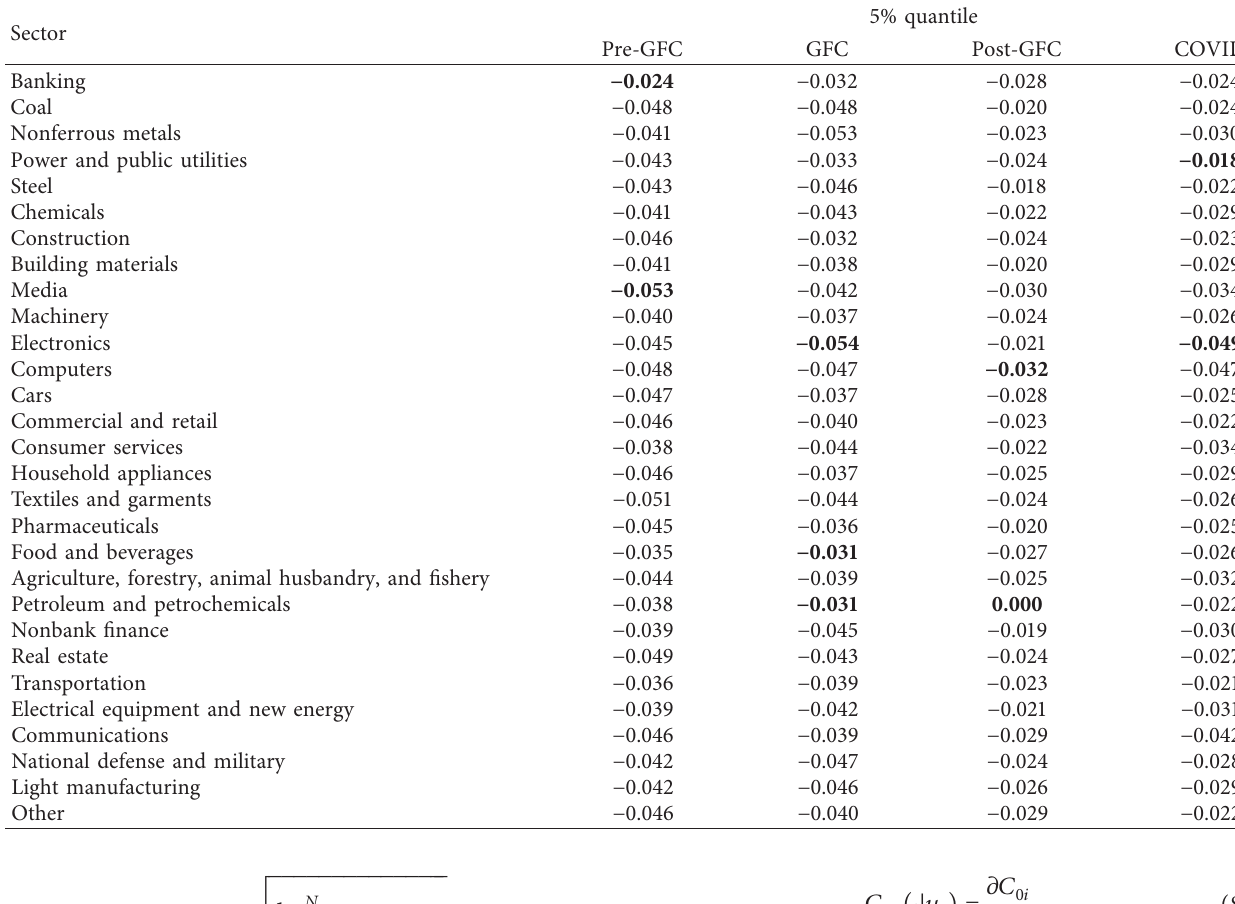
Table 1: Industrial sectors and their 5%